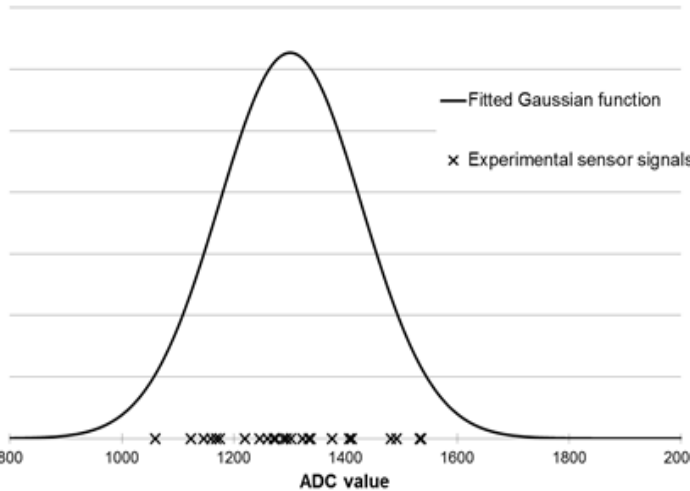
Figure 4. Gaussian membership function determined for TGS2603 sensor based on measurements of sample with odor intensity equal to 3 (distinct odor).